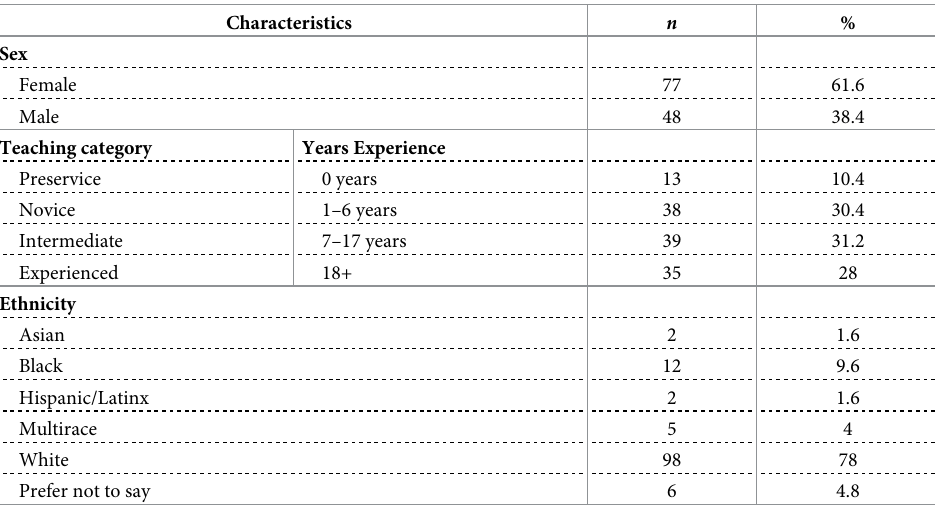
Table 2. Demographic characteristics of participants (N =